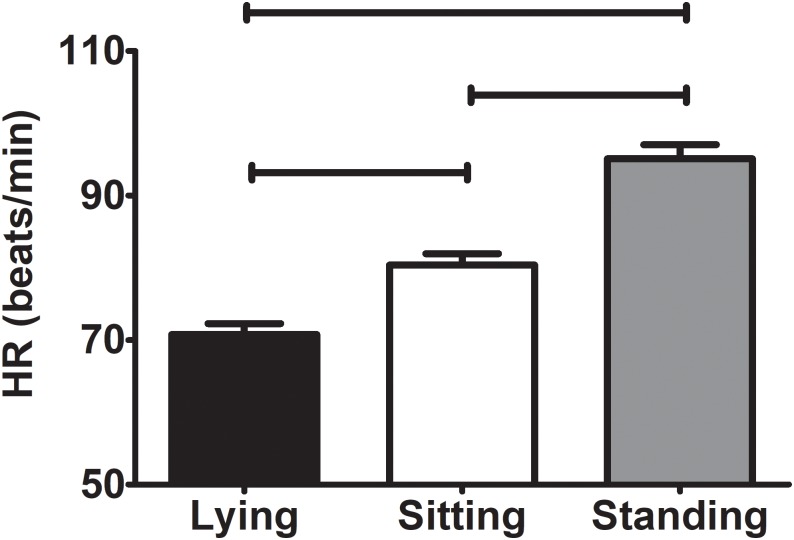
Heart rate (HR) in lying, sitting, and standing positions.Values are expressed as mean ± standard deviation. P value derived of repeated measures analysis of variance. Parallel lines mean P<0.001.